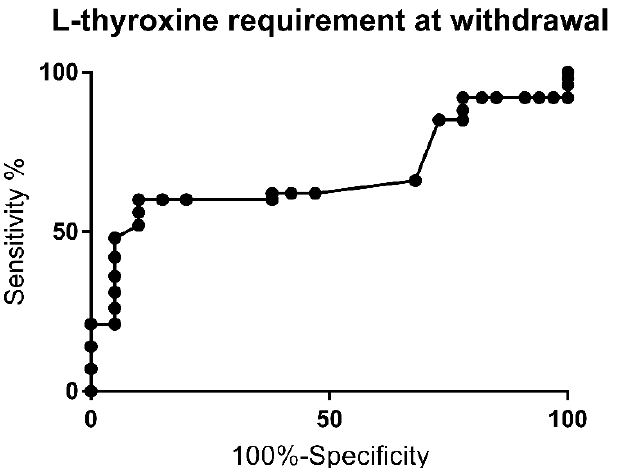
Figure 3. Receiver Operating Curve (ROC) for levothyroxine requirement upon withdrawal of therapy.